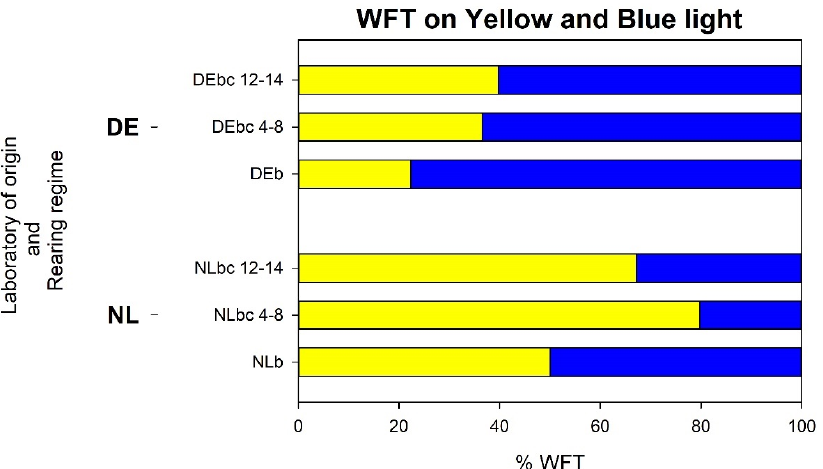
Figure 6. Experiment iii, analysis a : Stacked bar chart showing the percentages of WFT found on the yellow or blue light per laboratory of origin and rearing regime out of the total number of thrips that landed on the sticky glass plate of the LED lamp. Peak wavelength of LEDs: Blue (477 nm), Yellow (588 nm). DEb: colony of German WFT reared on bean pods for ~20 weeks; DEbc 4-8: DEb colony transferred and reared on yellow-flowered chrysanthemum plants for 4 to 8 weeks; DEbc 12-14: continuation of colony DEbc 4-8 until reaching 12 to 14 weeks reared on yellow-flowered chrysanthemum plants. NLb: colony of Dutch WFT reared on bean pods for ~20 weeks; NLbc 4-8: NLb colony transferred and reared on yellow-flowered chrysanthemum plants for 4 to 8 weeks; NLbc 12-14: continuation of colony NLbc4-8 until reaching 12 to 14 weeks reared on yellow-flowered chrysanthemum plants. All information from this figure including mean percentages and 95% confidence intervals is provided in Supplementary Table S8.